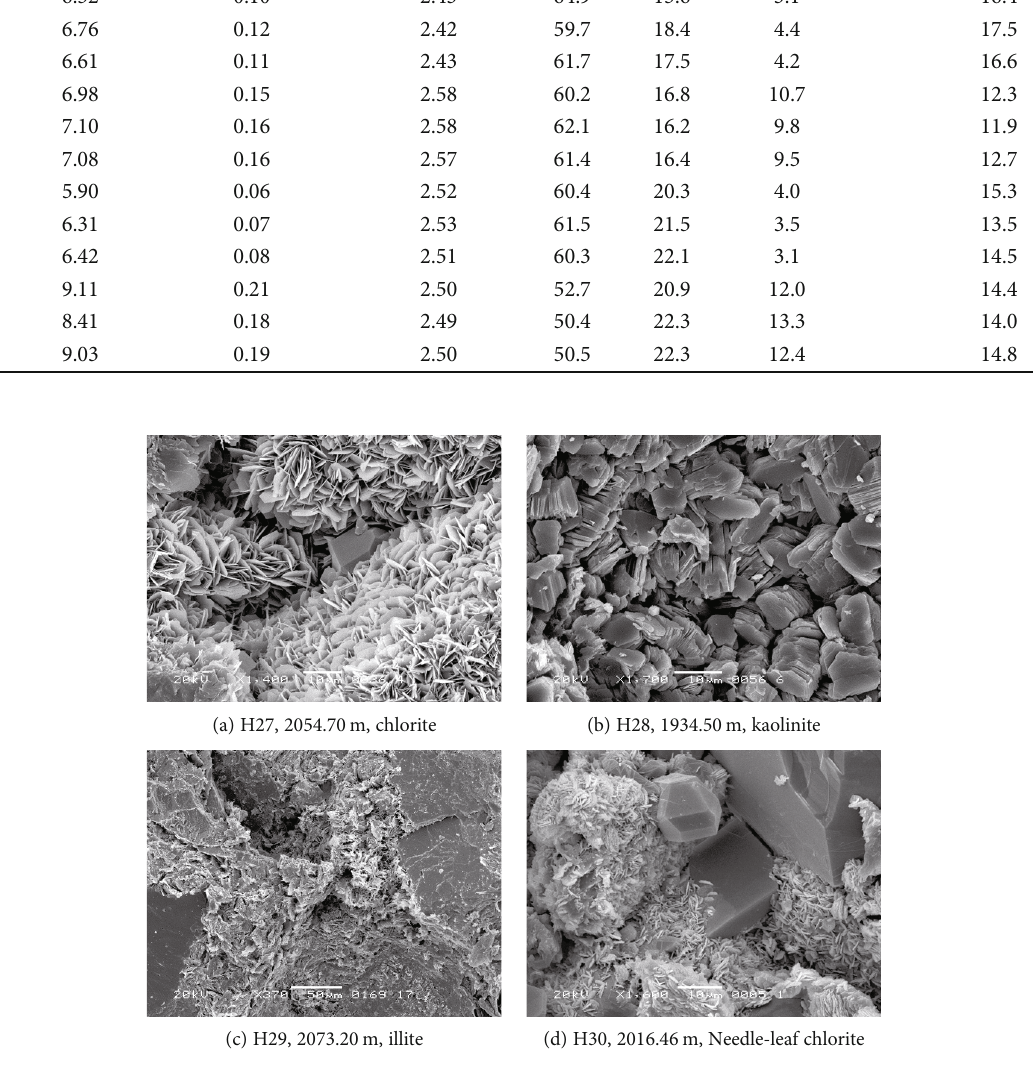
Figure 2: The occurrence characteristics of clay minerals of the Yanchang Formation in the Ordos